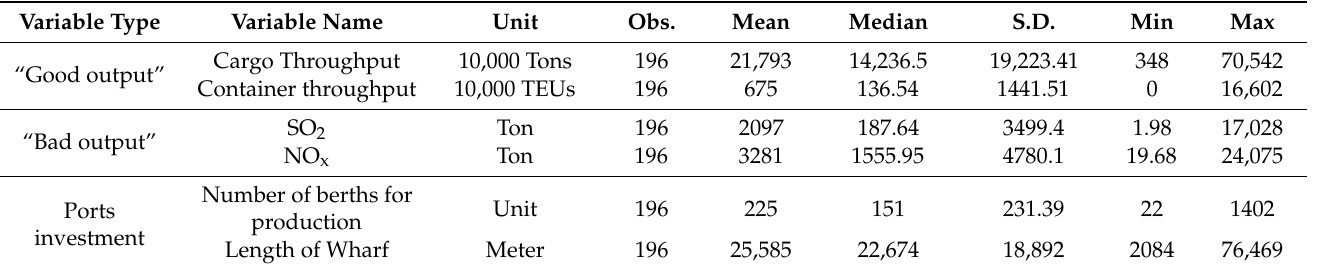
Table 2. Descriptive statistical results of input-output